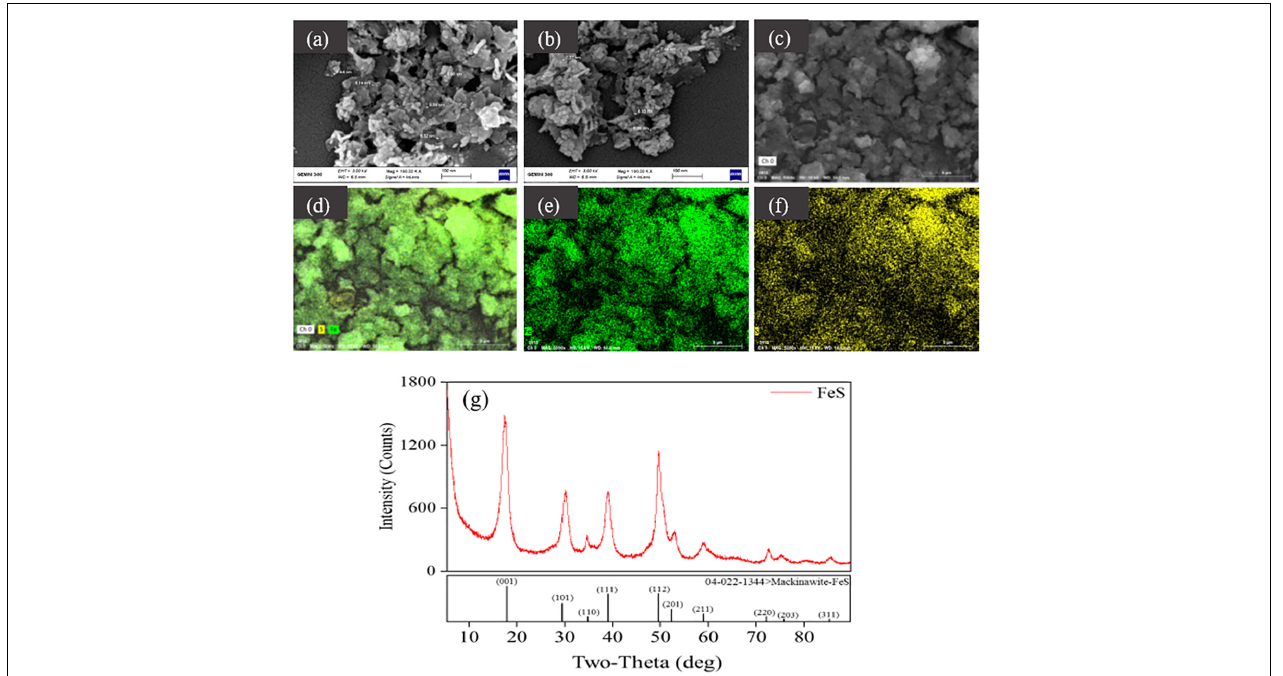
FIGURE 2 | Characterization of formed iron-sulfur nanoparticles with SEM-EDS (a–f) and XRD (g) .